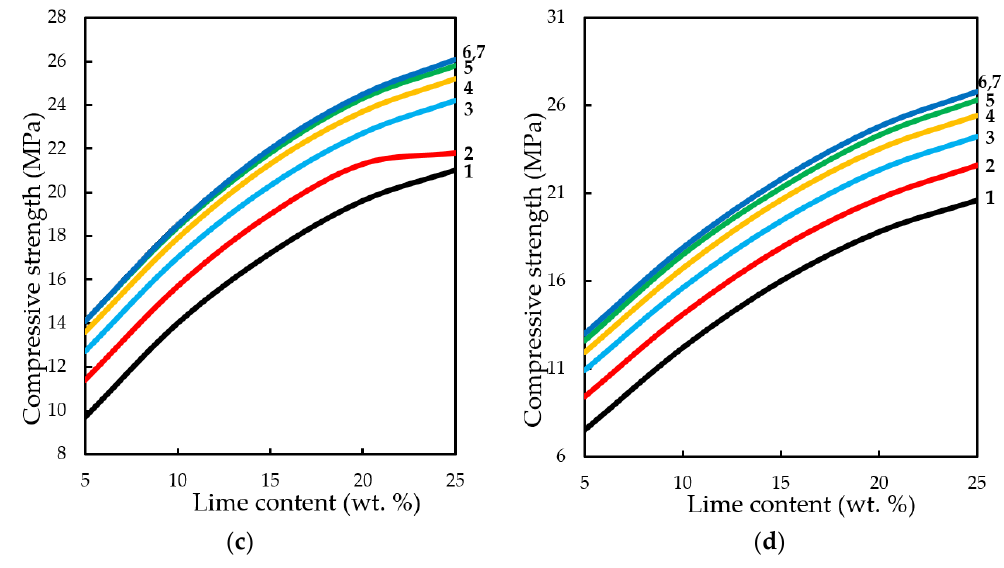
Figure 16. Variation in the compressive strength of testing samples manufactured at pressing pressure of: ( a ) 10; ( b ) 20; ( c ) 30; ( d ) 40 MPa. Samples carbonated by static method during 900 s, depending on the content of Ca(OH) 2 and concentration of СО 2 , %: 1— 10; 2— 20; 3 —30; 4— 40; 5 —50; 6 —60; 7 —65. with